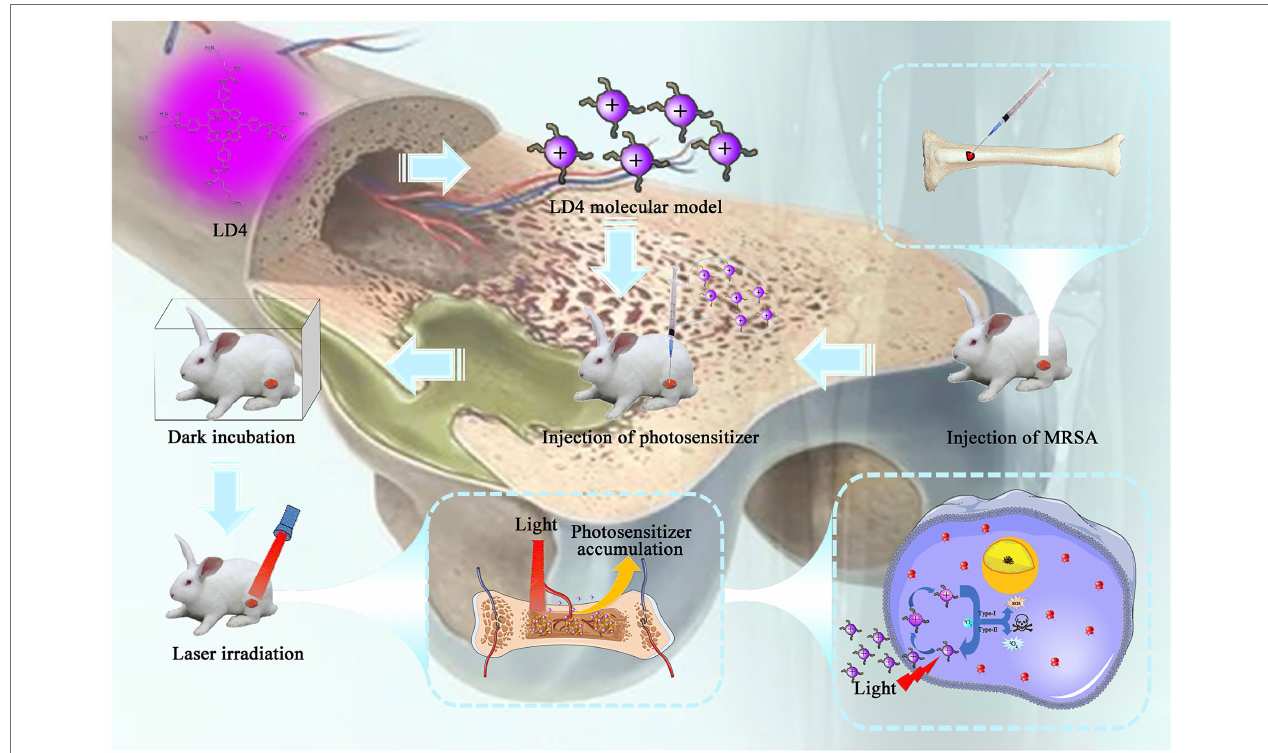
FIGURE 1 | The process and mechanism of LD4-PACT treating rabbit tibial